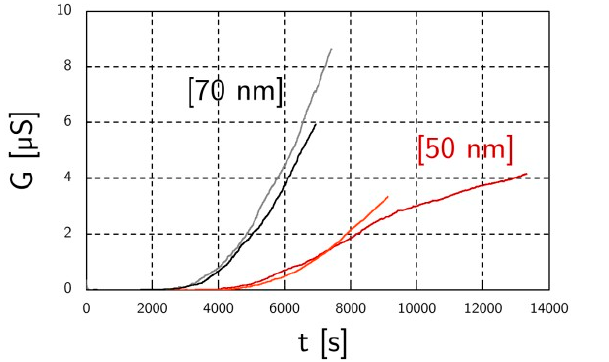
Figure 4. Soot sensor responses for two AAC classified aerosols: 50 nm and 70 nm (two tests for each